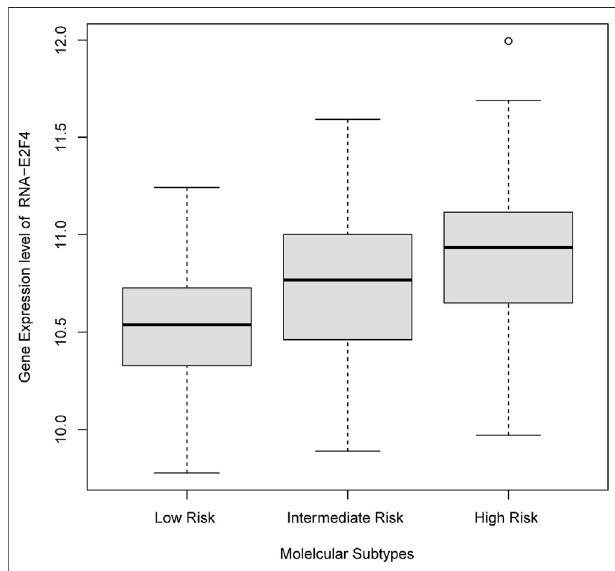
FIGURE 7 | E2F4 gene expression was elevated in the High-Risk Molecular